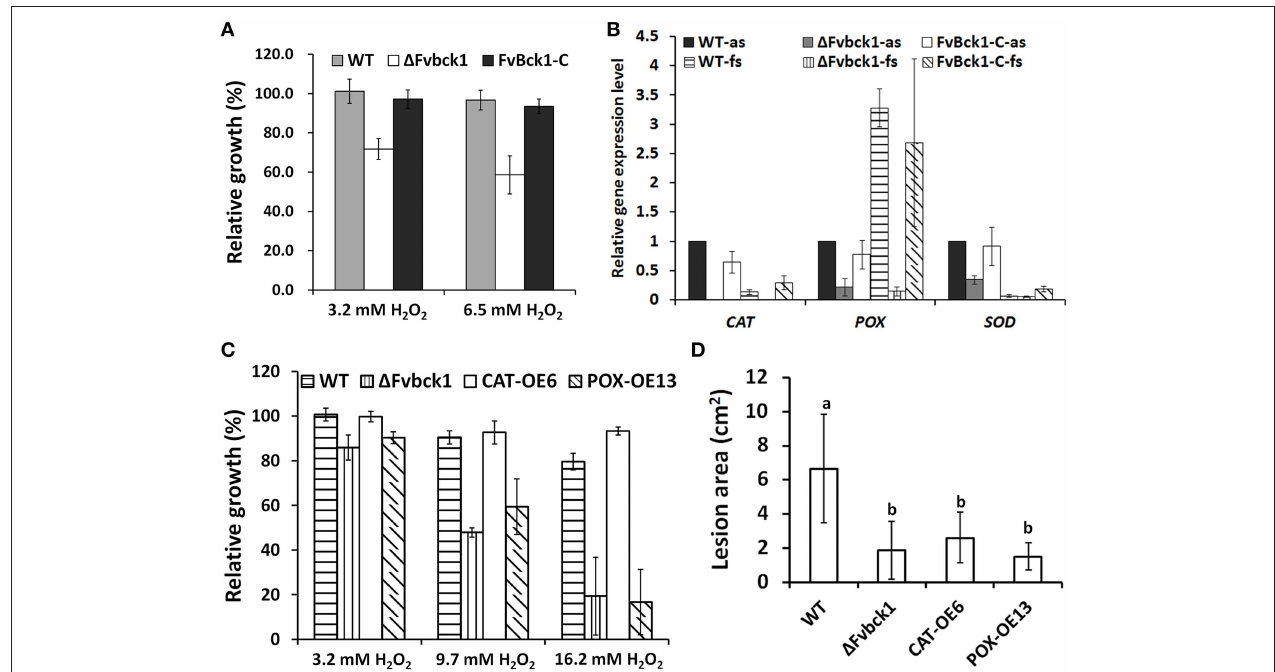
FIGURE 5 | The sensitivity to H 2 O 2 and virulence of WT, 1 Fvbck1, FvBck1-C, CAT-OE6, and POX-OE13 strains. (A) Relative growth of WT, 1 Fvbck1, and FvBck1-C strains grown on CM plates with different concentration of H 2 O 2 for 4 days. (B) Relative gene expression level of CAT (FV12888), POX (FV11221), and SOD (FV01940) of WT, 1 Fvbck1, and FvBck1-C strains grown in autoclaved or fresh sugarcanes for 7 days. The expression level of WT strain grown in autoclaved sugarcane was set to 1. as, autoclaved sugarcane; fs, fresh sugarcane. (C) The relative growth of WT, 1 Fvbck1, CAT-OE6, and POX-OE13 strains grown on CM plates with different concentration of H 2 O 2 for 3 days. (D) Lesion area of each rip cut sugarcane stem infected by each strain for 7 days. Mean and standard error were calculated from three independent biological replicates. Different letters were used to mark statistically significant difference ( P < 0.05